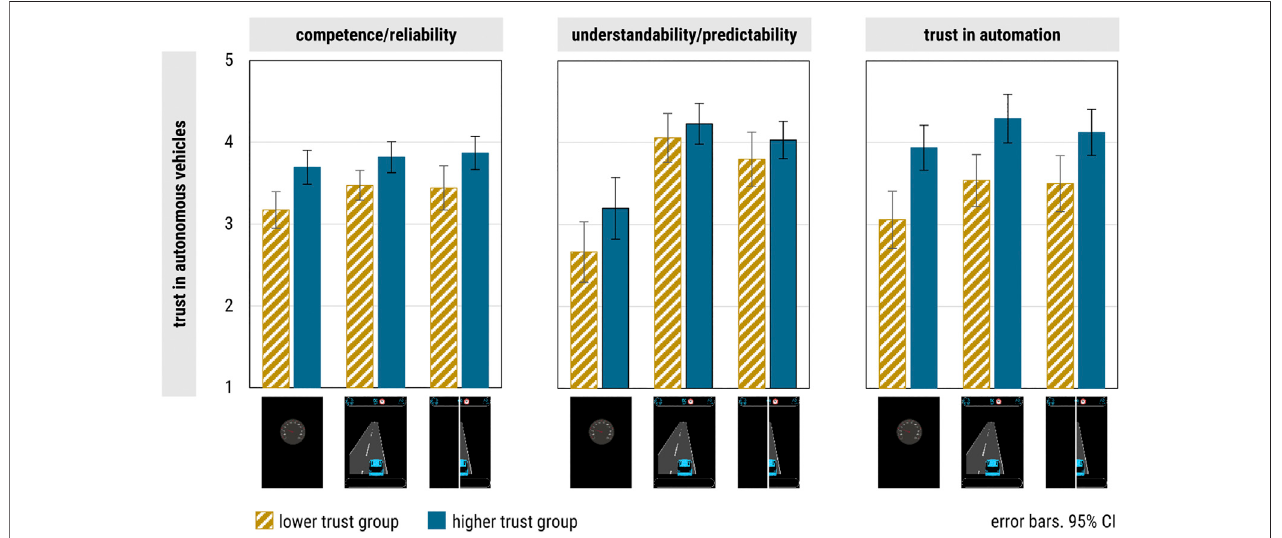
FIGURE5| Trustgroup-speci fi ctrustinautomatedvehiclesreportedafterautomateddrivingwithno (left) ,permanent (middle) andcontext-adaptive (right) HMI.